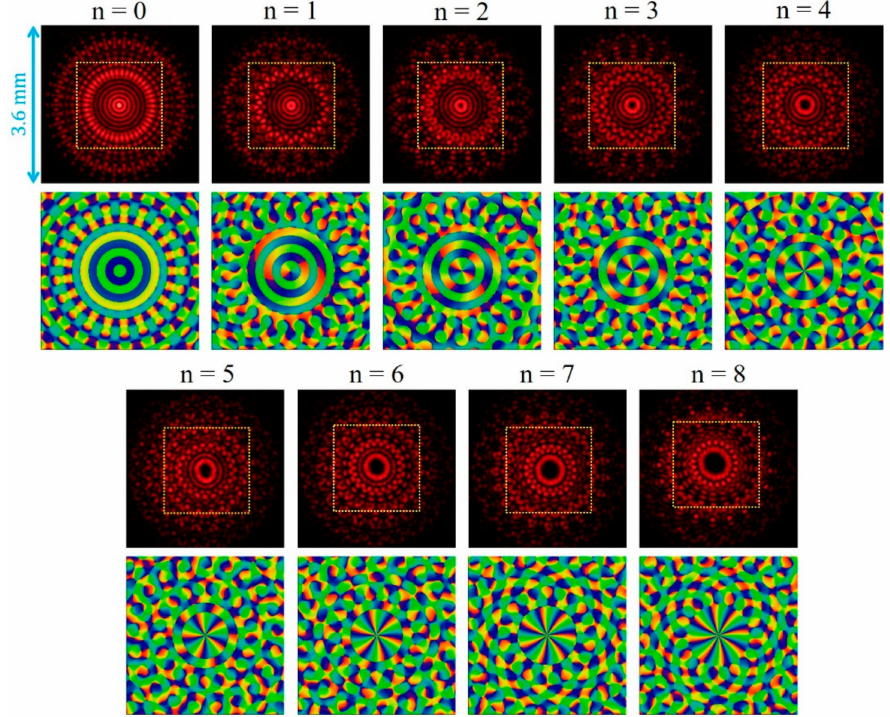
Figure 5. Experimental interference patterns and the corresponding phase fields for the case of Q = 21 with various relative